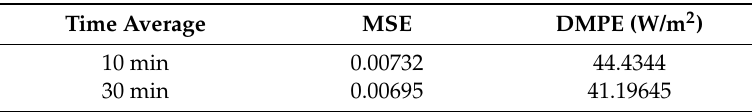
Table 3. Choice of the time average of the database.